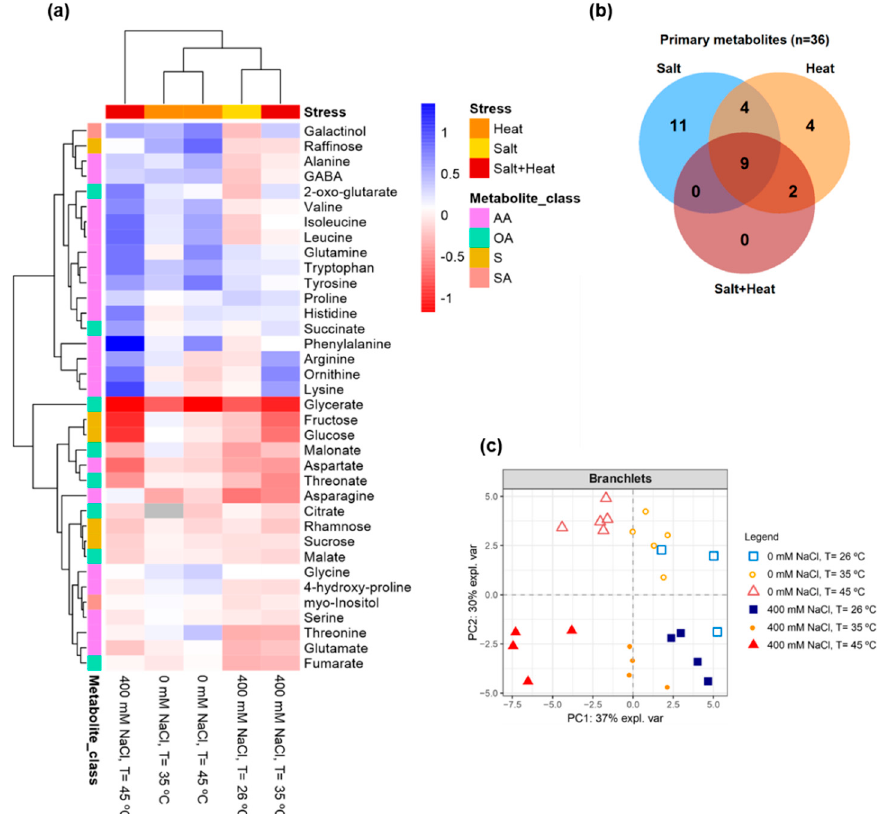
Figure 6. GC-TOF-MS primary metabolite profiling analysis. ( a ) Heatmap showing metabolite re- sponses in C. glauca branchlets under the single and combined exposure to salt (0 and 400 mM NaCl) and temperature (26, 35 and 45 °C) conditions. Relative values are normalised to the internal standard (ribitol) and dry weight (DW) of the samples. False-colour imaging was performed on Log 10 -transformed GC-TOF-MS data. Grey-colour squares represent not detected (n.d.) values. AA-amino acids, OA-organic acids, S-sugars, SA-sugar alcohols. ( b ) Venn diagram showing the number of metabolites which levels were shown to significantly change in C. glauca branchlets under the single and combined exposure to salt (0 and 400 mM NaCl) and temperature (26, 35 and 45 °C) conditions. Two-way ANOVA ( p < 0.05) followed by Tukey´s HSD test was performed for means comparison. ( c ) Principal component analysis (PCA) score plots of the primary metabolite profiles in the branchlets of C. glauca plants under the single and combined exposure to salt (0 and 400 mM NaCl) and temperature (26, 35 and 45 °C) conditions.